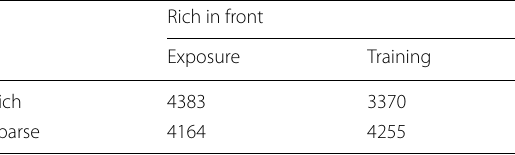
Table 1 Mean RT in milliseconds by condition Rich in front